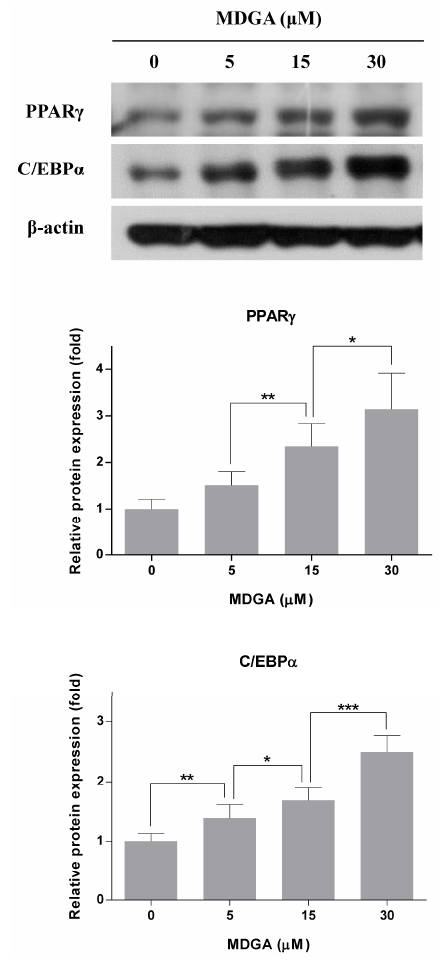
Figure 2. Increased effect of MDGA on PPAR γ and C/EBP α expressions. The differentiation of preadipocytes was induced with adipogenic mixture containing 0.1 μ g/mL insulin, 0.5 mM IBMX, and 1 μ M dexamethasone. Cells were simultaneously treated with MDGA (0, 5, 15, or 30 μ M) every other day during the first 4 days of differentiation. On day 6, cells were harvested and the lysates were subjected to Western blot analysis for PPAR γ and C/EBP α . The intensity of each band was quantified by the WCIF Image J for Windows Program. All values are presented as the mean ± SD of three experiments performed in triplicate. Statistical significance: * p < 0.05, ** p < 0.01, *** p < 0.001.